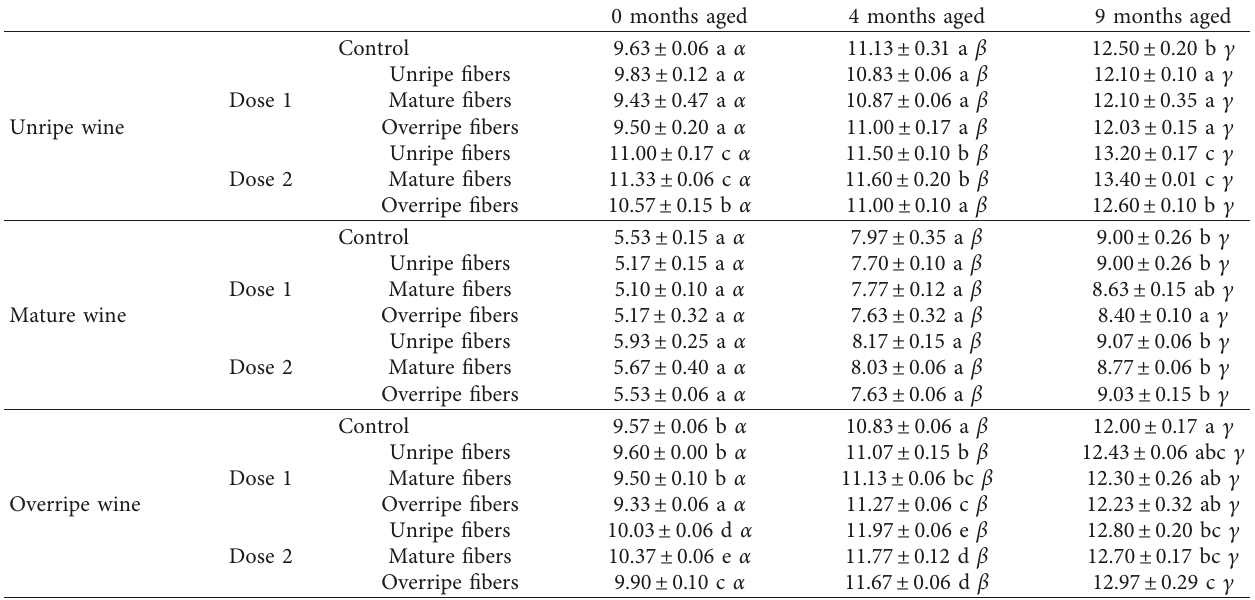
Table 6: Lightness ( L ∗ ) of the wines.